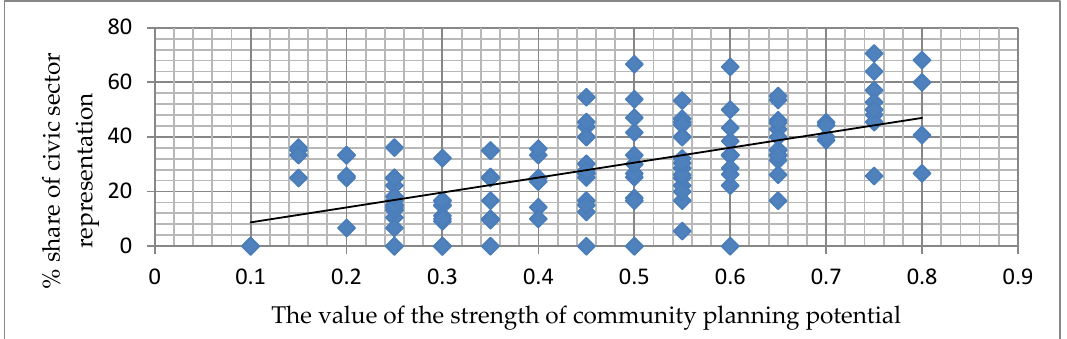
Figure 2. Linear line—the case of civic sector impact on the utilization of the Community planning potential. Source: Own processing.